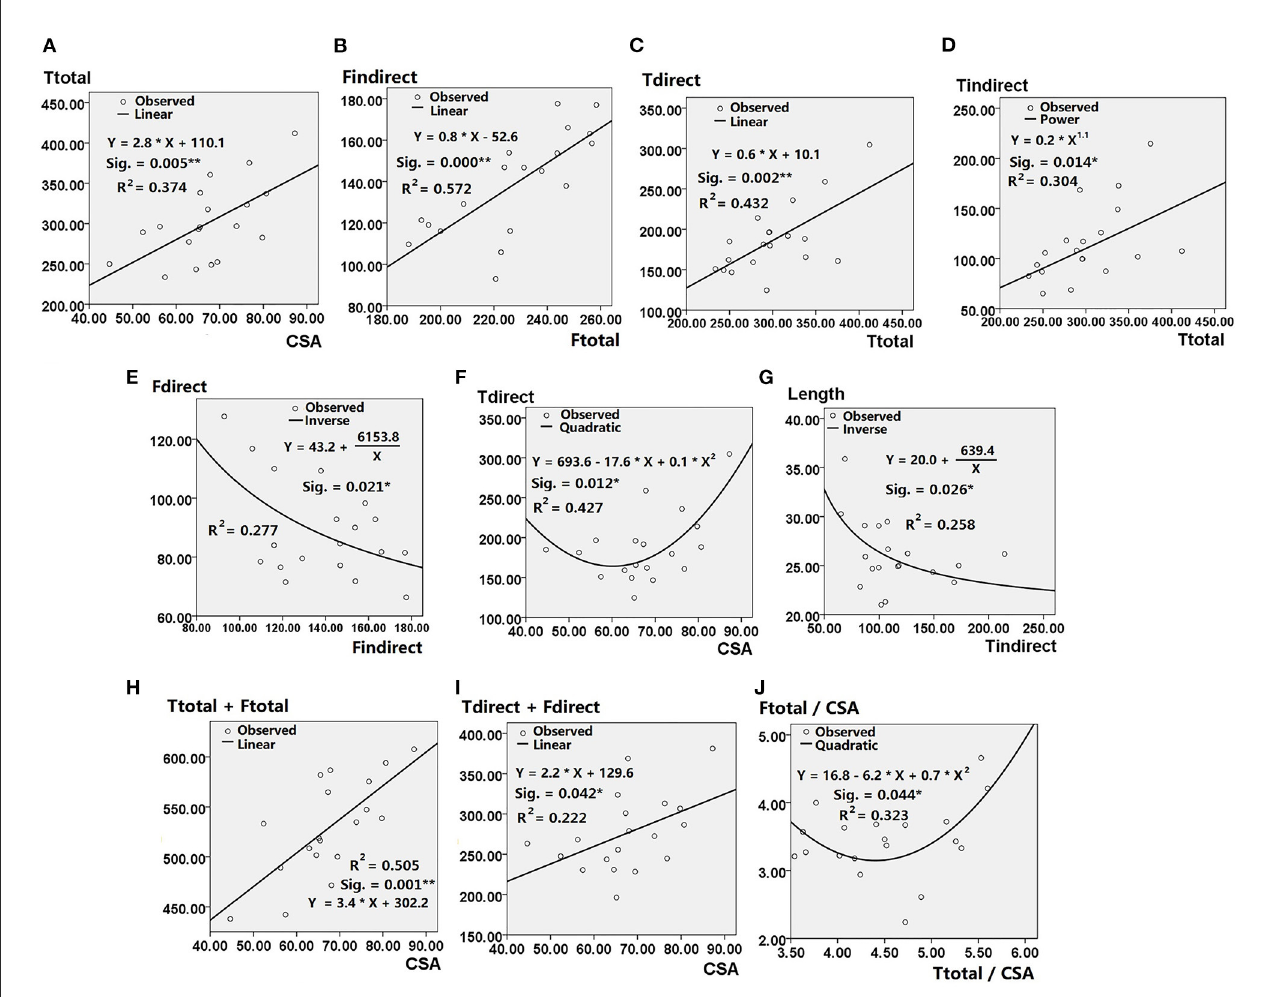
FIGURE5 Results of nonlinear regression analysis showing statistical significance (Sig.), coefficient of determination ( R 2 ), Best-fit curves and the equations depicting correlation between (A) Ttotal and CSA; (B) Findirect and Ftotal; (C) Tdirect and Ttotal; (D) Tindirect and Ttotal; (E) Fdirect and Findirect; (F) Tdirect and CSA; (G) Length and Tindirect; (H) Ttotal + Ftotal and CSA; (I) Tdirect + Fdirect and CSA; (J) Ftotal/CSA and Ttotal/CSA. CSA, cross-sectional area of ACL isthmus; Fdirect, area of direct femoral insertion site; Findirect, area of indirect femoral insertion site; Ftotal, area of total femoral insertion site; Tdirect, area of direct tibial insertion site; Tindirect, area of indirect tibial insertion site; Ttotal, area of total tibial insertion site; Length, length of ACL. * Represents p < 0.05 when ** represents p <